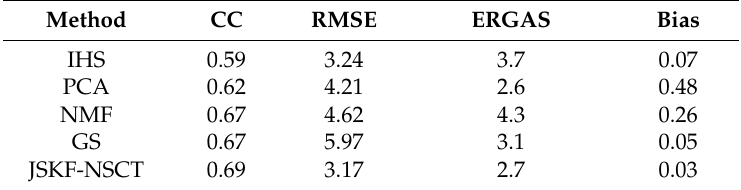
Table 9. Comparison of another four evaluation indices for five fusion methods.